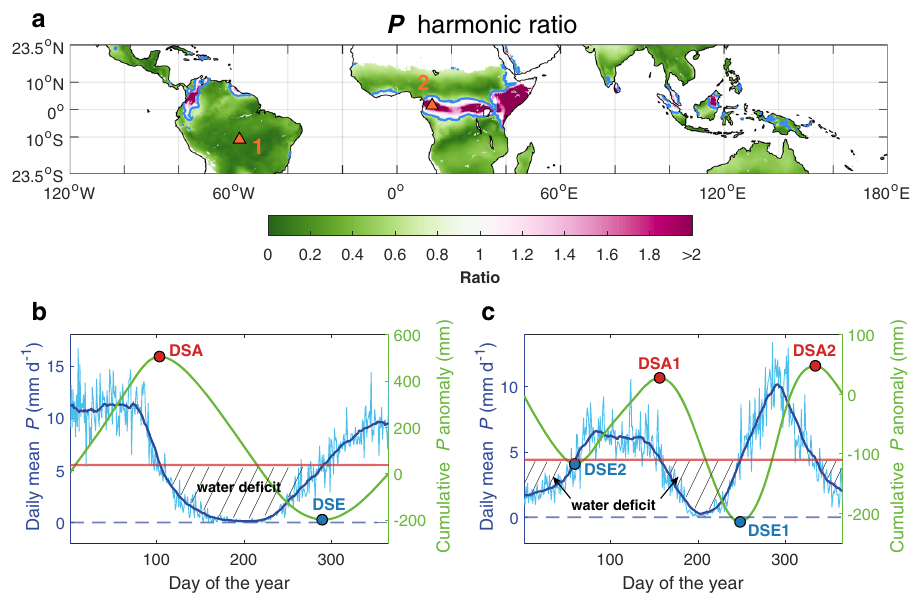
-- P . a The mean ratio of P amplitudes of the harmonics at frequencies of two and one cycle Fig. 1 Precipitation seasonality and dry season de fi ned as P < per year via Fourier Analysis of whole daily time series (1983 – 2016) for each grid box based on the eight precipitation datasets. The blue line marks the boundaries with the ratio of 0.75, inside which grid boxes have two wet seasons and two dry seasons per year. b , c Daily mean rainfall (light blue) for each day of the year, smoothed using a 30-day running window (blue), the multi-year average daily mean precipitation (red horizontal line), and cumulative P anomaly value (green) for the grid box centered at 11.125°S, 57.875°W (left, point 1 in a ) and 1.375°N, 12.875°E (right, point 2 in a ) according to the daily CHIRPS precipitation dataset for the period 1983 – 2016 (see Eq. 3). Red dots mark the arrival of dry seasons (DSA), while blue dots mark the end of dry seasons (DSE). The solid black shaded area represents the water de fi cit, calculated as the cumulative difference between P and (cid:1) P during the dry season. The two longest seasons are assumed to be the two seasons of interest for the biannual region ( c ). Similar patterns and de fi nitions for P < Ep and P < E are shown in Supplementary Figs. 2,